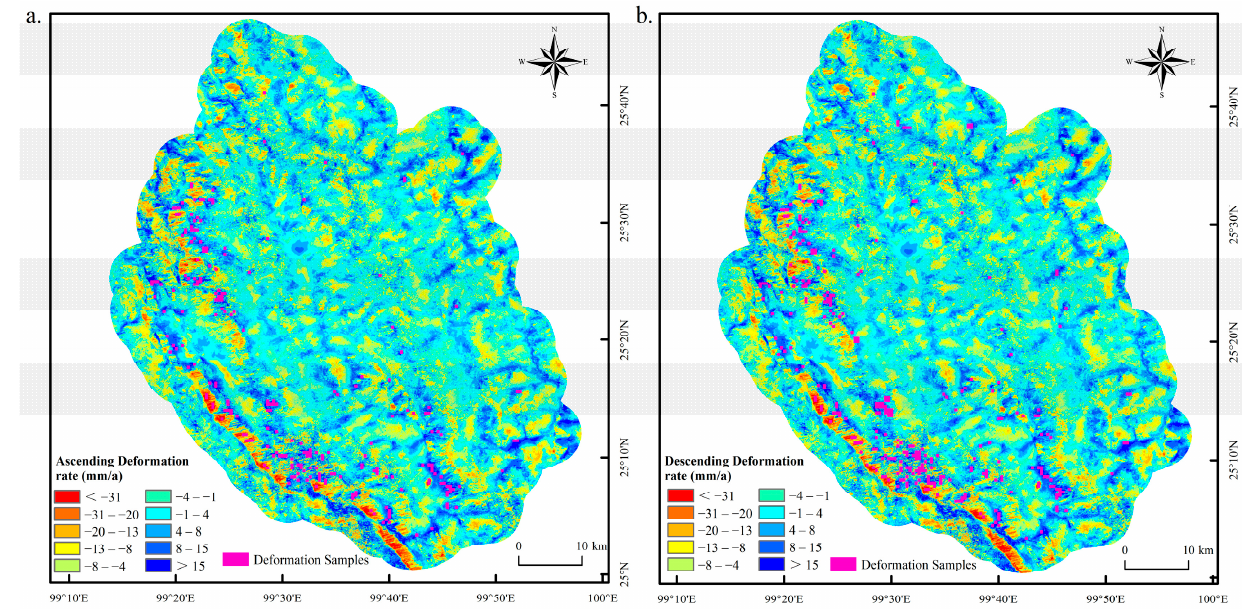
Figure 4. InSAR deformation processing results. ( a ) Ascending deformation rate results, ( b ) Descending deformation rate results.